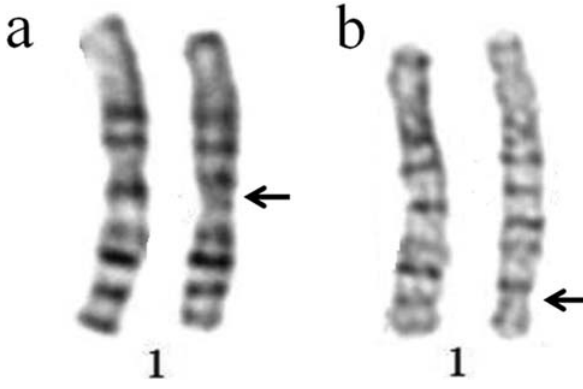
Figure 1: Abnormal karyotypes possessing pericentric inversion in chromosome 1. ( a ) Karyotype of the fi rst case and ( b ) karyotype of the second